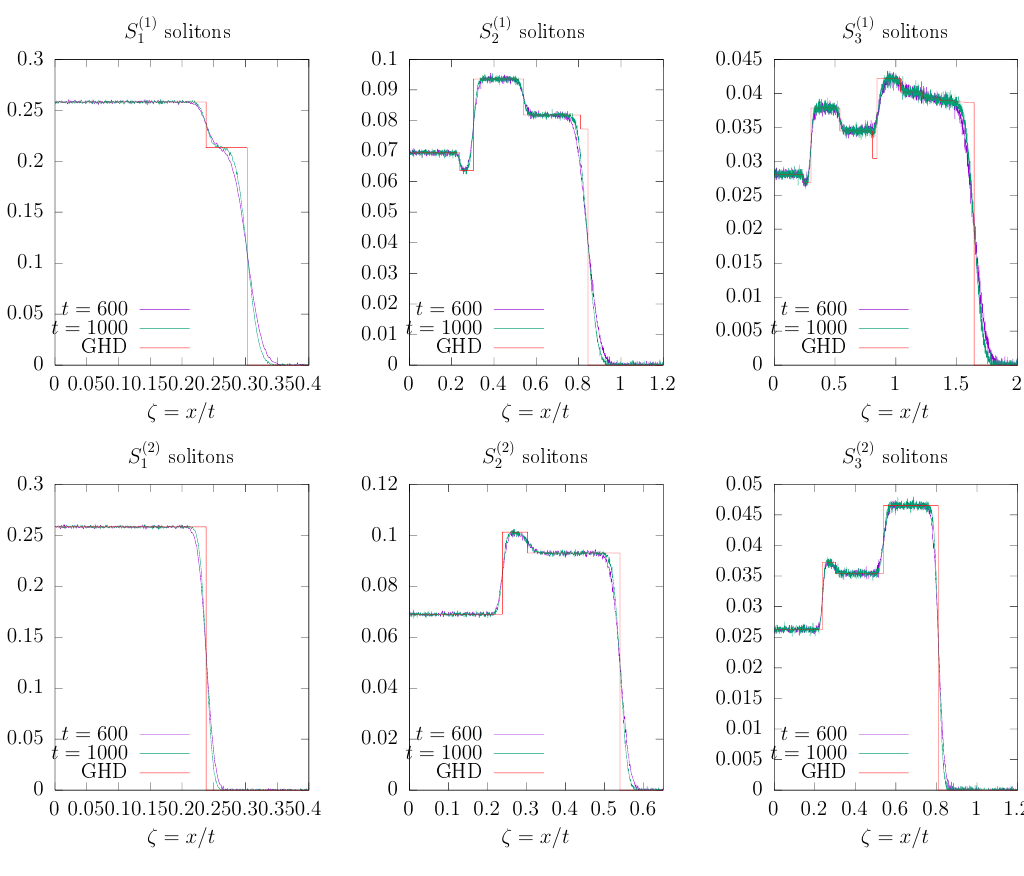
( a ) Figure 1: Numerical results for several S -soliton densities (with sizes k = 1 , 2 , 3 k and ‘color’ a = 1 , 2 ) as a function of ζ = x/t for t = 600 and t = 1000 and for (1) the T dynamics. The red line indicates the GHD prediction for t = l =100 initial state is defined by the following fugacities in the left half: z 1 ,L = 1 z 2 ,L = 0 . 7 and z 3 ,L = 0 . 3 . The right half is initially in the vacuum state. Parameters of the simulations: system size L = 300000 and number of random initial conditions N = 400000 samples